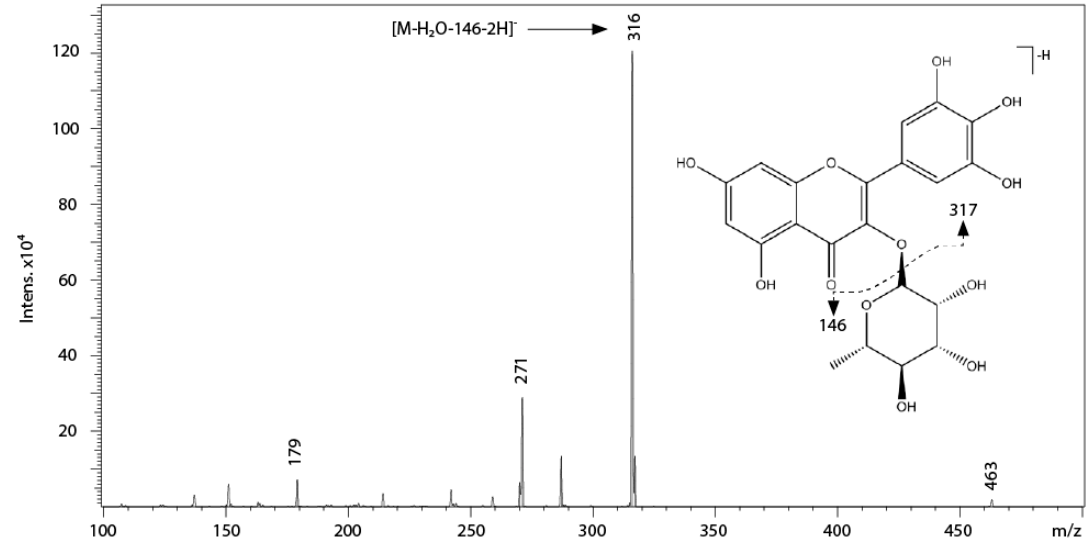
Figure 3. Structure, fragmentation and MS/MS spectrum of peak 12 (myricitrin). Solid arrow indicates the most abundant ion in myricitrin fragmentation; dashed arrow indicates the loss of rhamnose moiety.